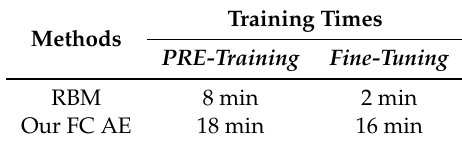
Table 5. Training times for the different